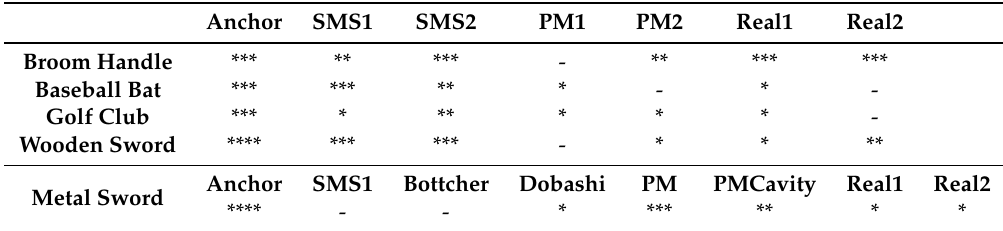
Table 3. Results for Shapiro–Wilk test for the plausibility ratings (**** ⇒ p < 0.0001, *** ⇒ p < 0.001, PMCavity, physical model including cavity tone; Real, recorded sample.